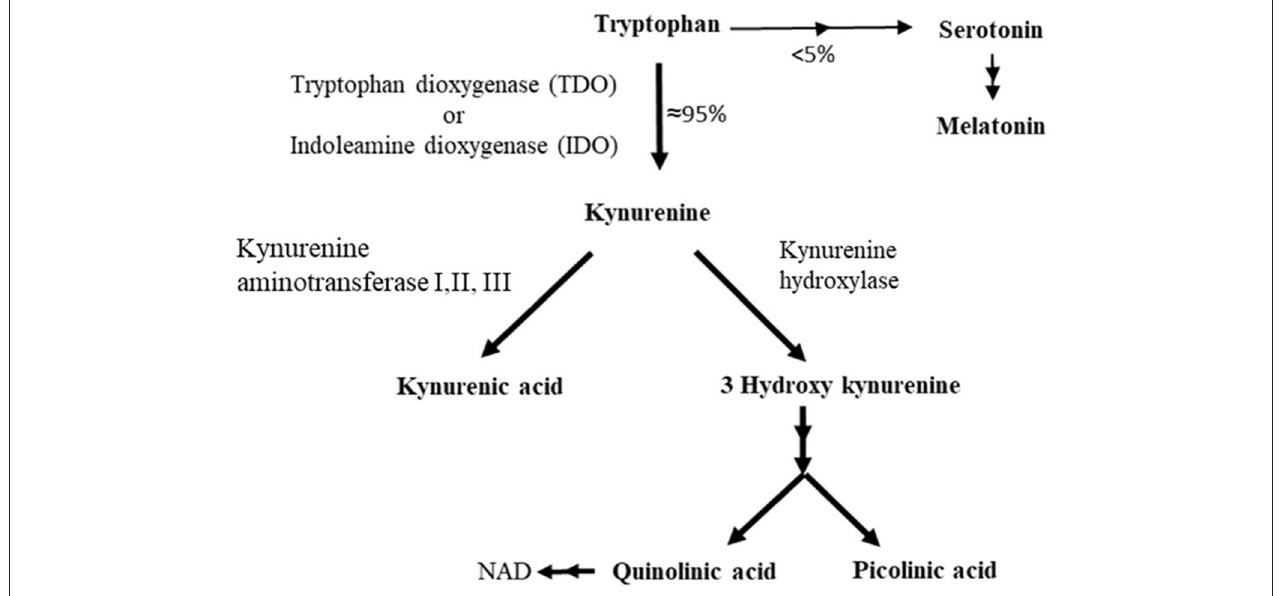
FIGURE 3 | Major metabolic pathway of tryptophan in